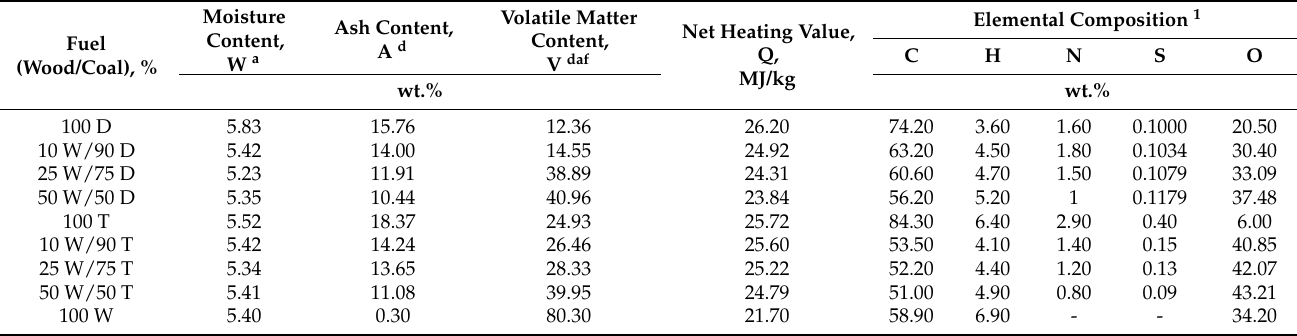
Table 1. Characteristics of fuel components and their elemental composition. Moisture Fuel (Wood/Coal), %